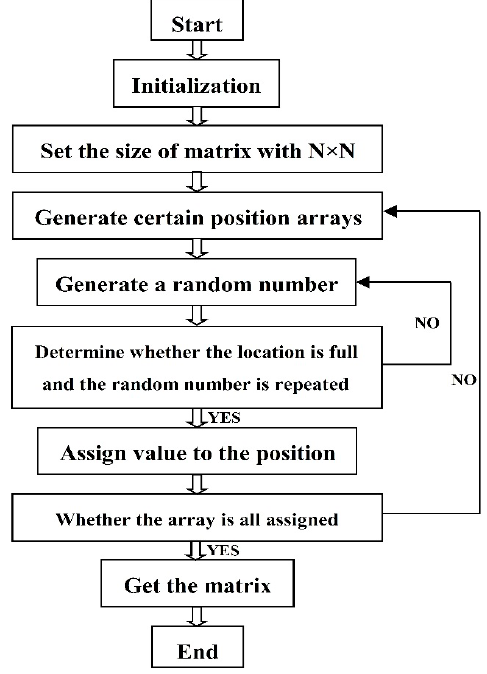
Figure 1. Matrix-type random coding flowchart.